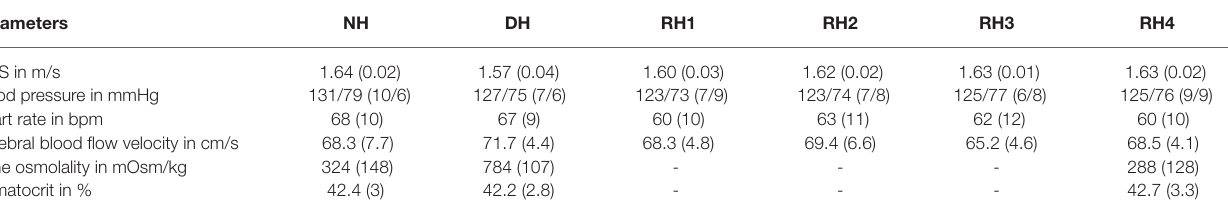
TABLE 2 | Group mean values (standard deviation) across volunteers (#5 and #12 excluded) for all physical parameters obtained including shear wave speed (SWS), blood pressure, heart rate, cerebral blood flow velocity, and urine osmolality.